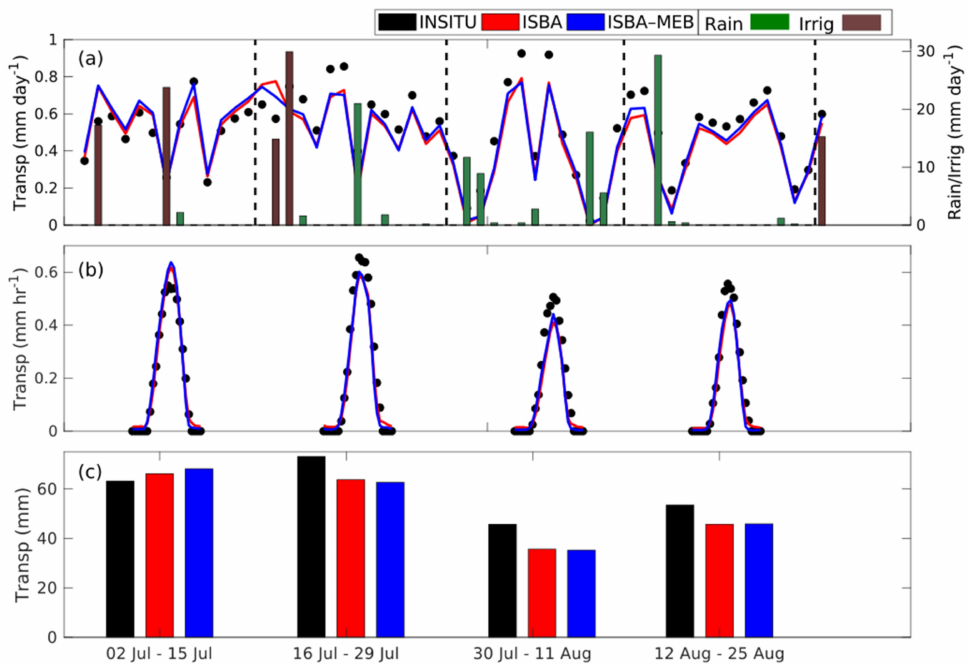
Figure 9. ( a ) Daily time series comparing sap flow measurements (black) with estimations from ISBA (red) and ISBA-MEB (blue) and the cumulative rainfall with irrigation in mm between 2 July and 25 August 2015. ( b ) Diurnal trend of transpiration averaged over a 13/14 days’ periods. ( c ) Comparison of the cumulative transpiration over the time period in ( b